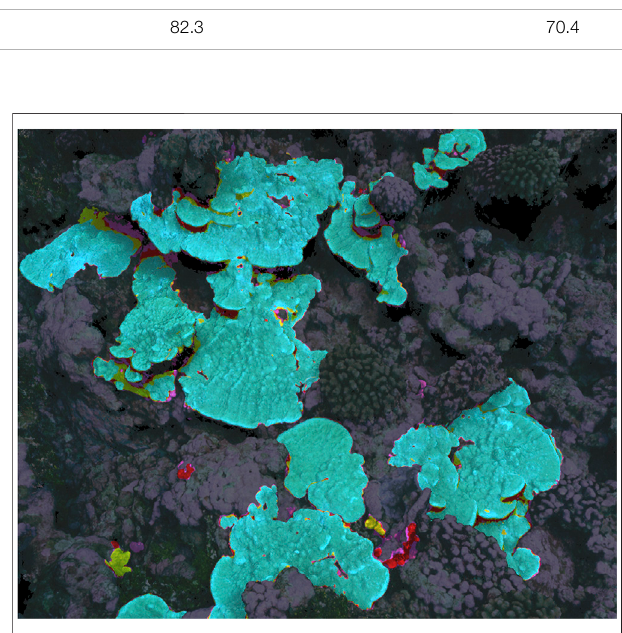
FIGURE 1 | 3D model showing agreement and disagreement amongst manual segmenters. Dark background is consensus background, while blue highlights show agreed-upon Porites by all four segmenters. Points highlightedyellowwerelabeled Porites bythreesegmenters,redbytwo, and purple by only